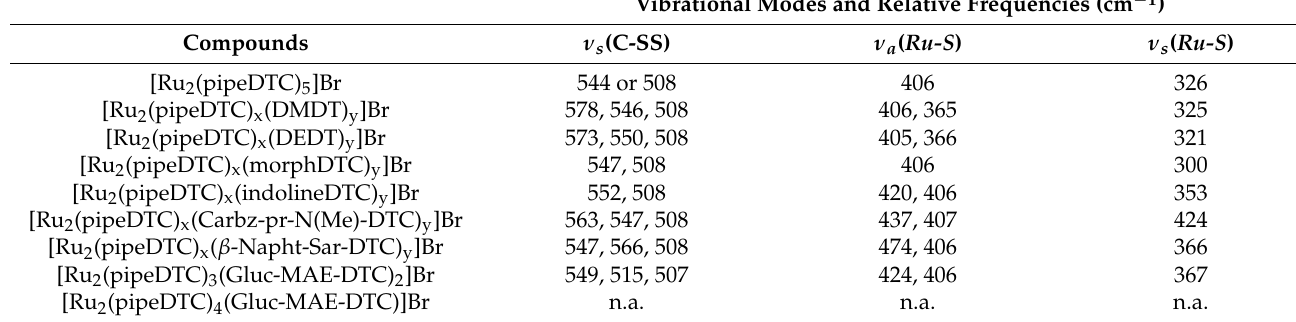
Table 3. Collection of the main IR-vibrations (4000–800 cm − 1 ) of the synthesized binuclear Ru(III)- DTC